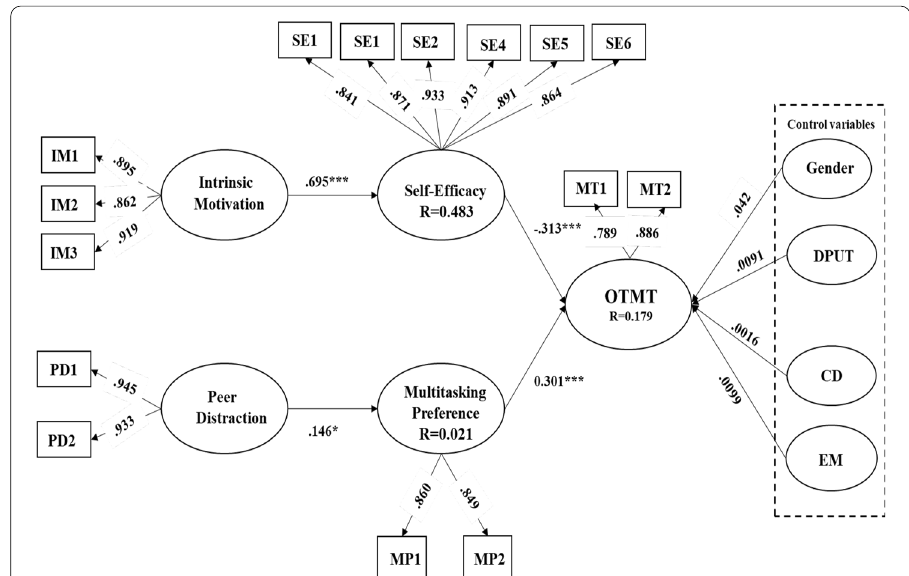
Fig. 3 Results for the main model. * p < 0.05; ** p < 0.00; *** p < 0.001